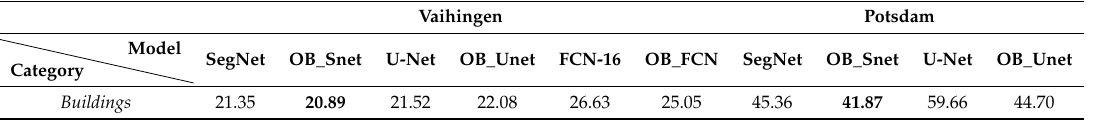
Table 4. The calculated mean Hausdorff distance (HD) between the predicted and reference Buildings pixels for the Vaihingen and Potsdam datasets.